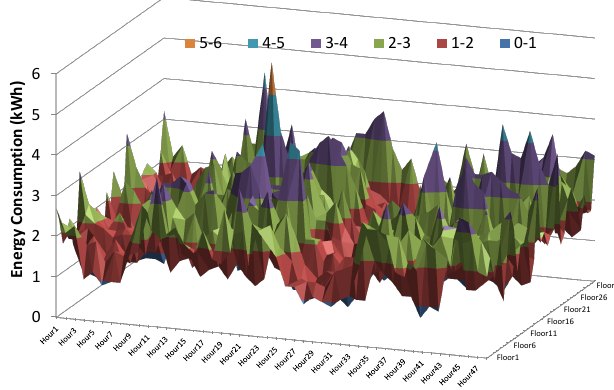
Figure 7. Sample data (two days) of hourly energy consumption in Building- IV